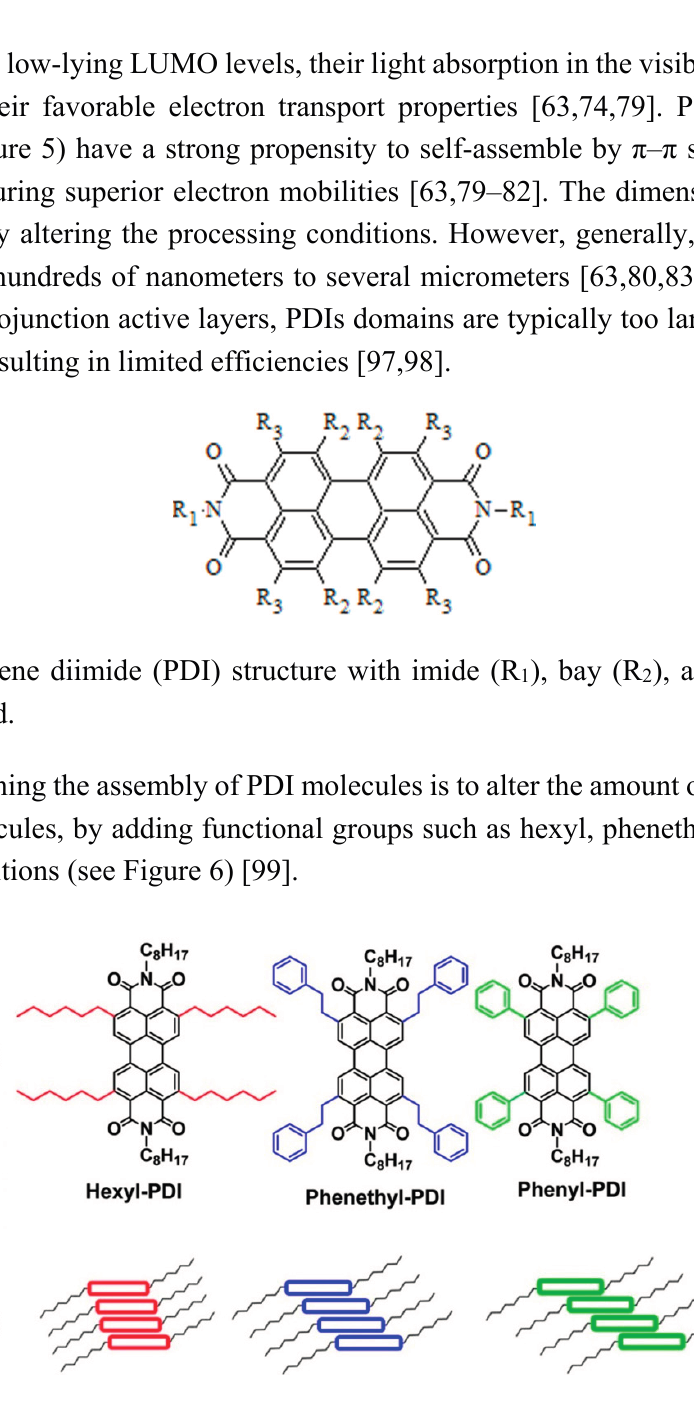
Figure 6. ( A ) Molecular structure of PDI derivatives and ( B ) the hypothesized degree of slip-stacking. Adapted from [99] with permission from the American Chemical